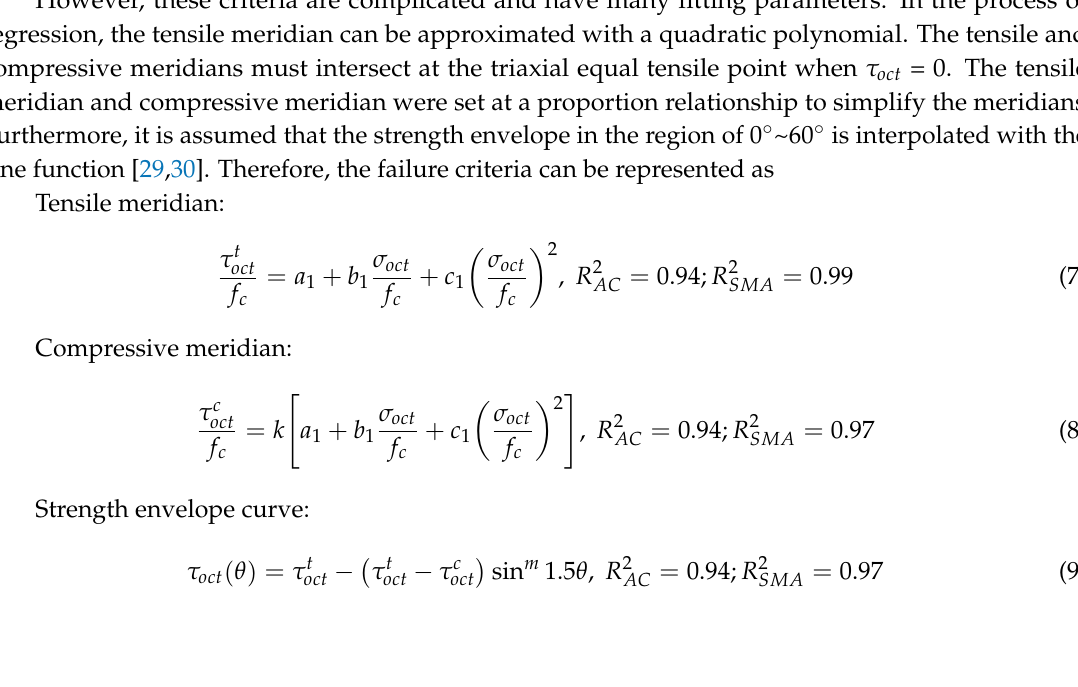
Figure 9. Nonlinear strength envelope curves in the -plane.